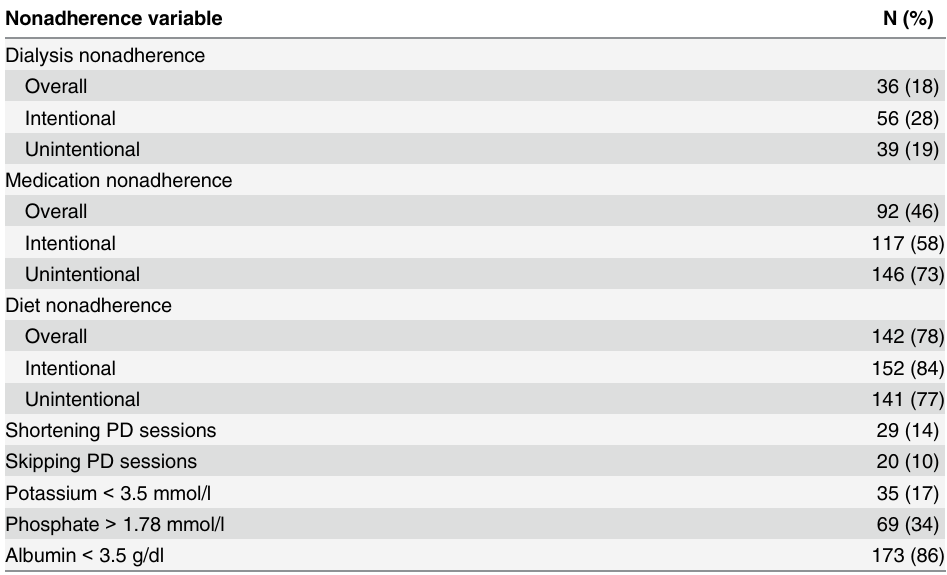
Table 2. Adherence results based on self-report and biochemical